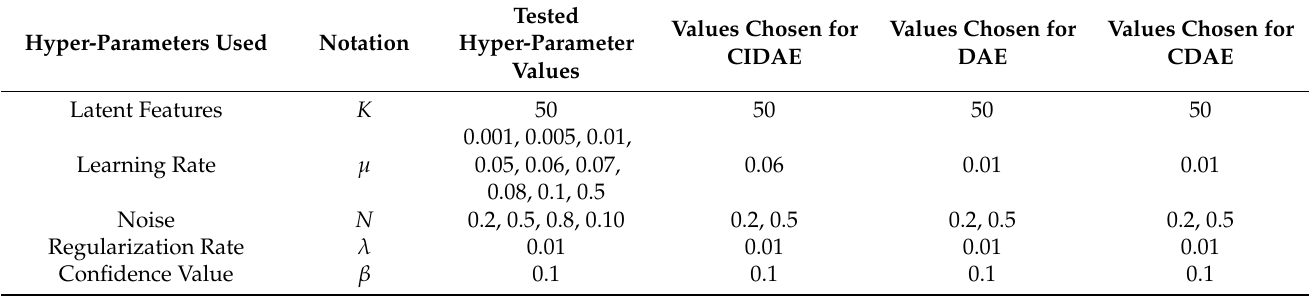
Table 2. Parameters for